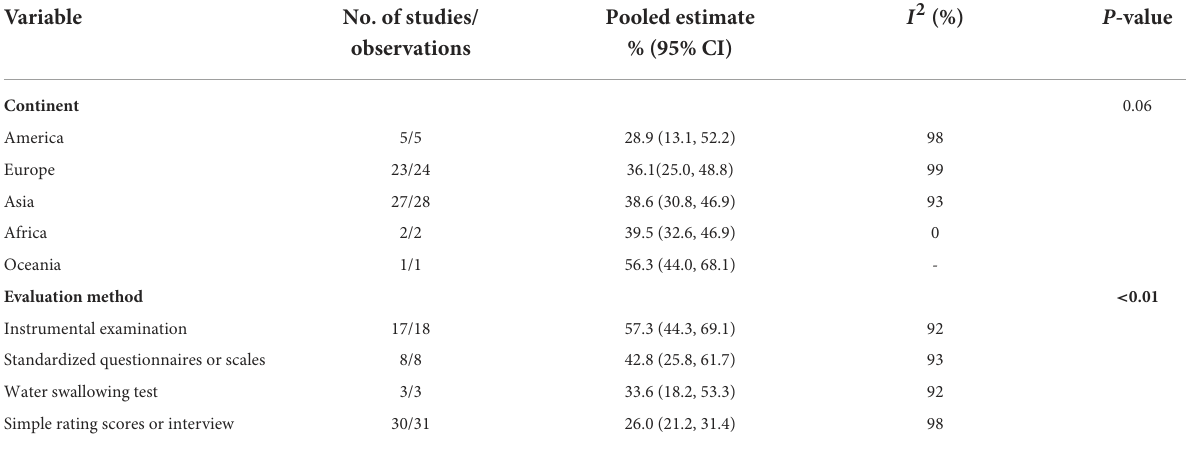
TABLE 2 Subgroup analyses of the prevalence of dysphagia in PD based on random-effect analysis.